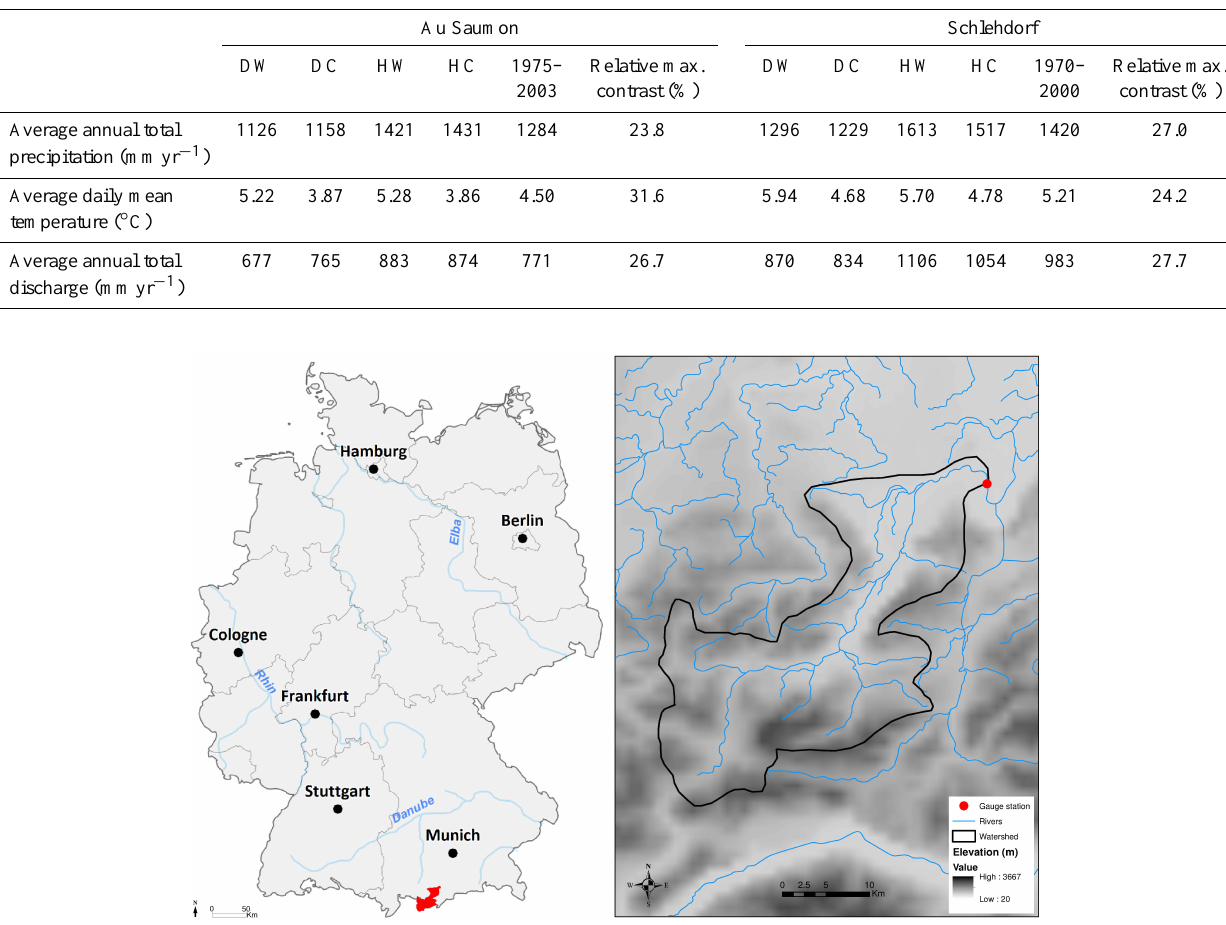
Fig. 2. Location of the Schlehdorf catchment (708km 2 ;